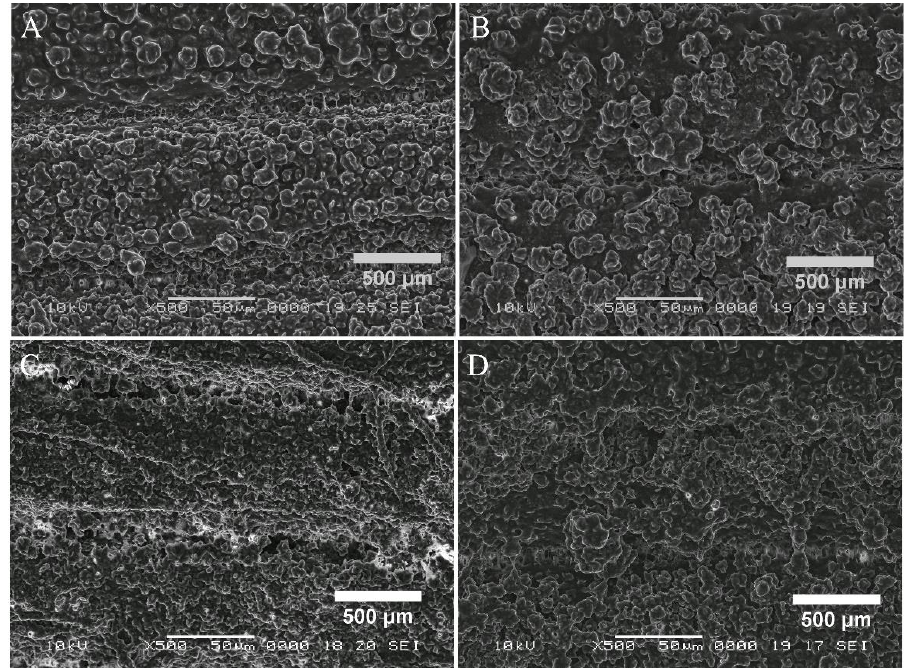
Figure 7. Scanning electron microscopy (SEM) images at X500 magnification, showing bacterial growth on the 3D-printed PLA microfluidic devices. ( A ) = Enterococcus faecalis , ( B ) = Staphylococcus aureus , ( C ) = Klebsiella pneumoniae and ( D ) = Pseudomonas aeruginosa . The strains used were Staphylo- coccus aureus ATCC 25923, Enterococcus faecalis ATCC 29212, Klebsiella pneumoniae ATCC 13883 and Pseudomonas aeruginosa ATCC 27853